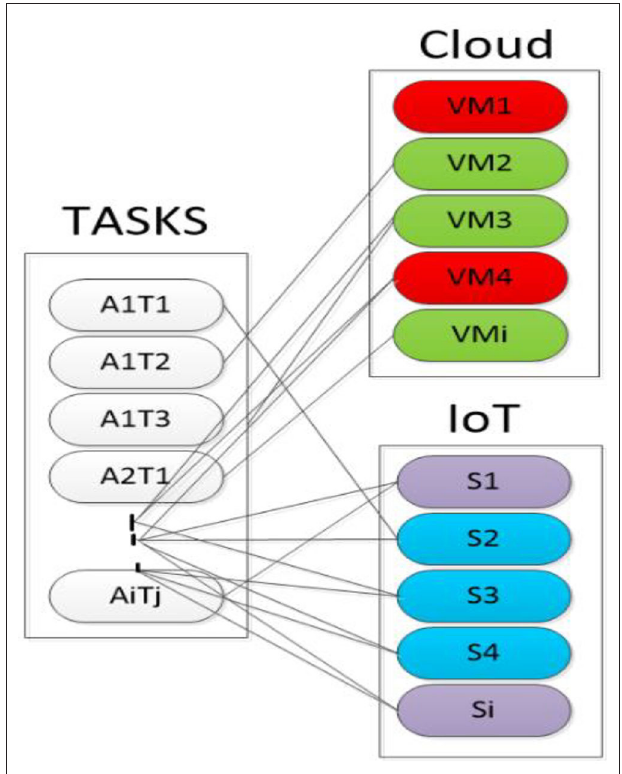
FIGURE 4 | Task strategy in cloud